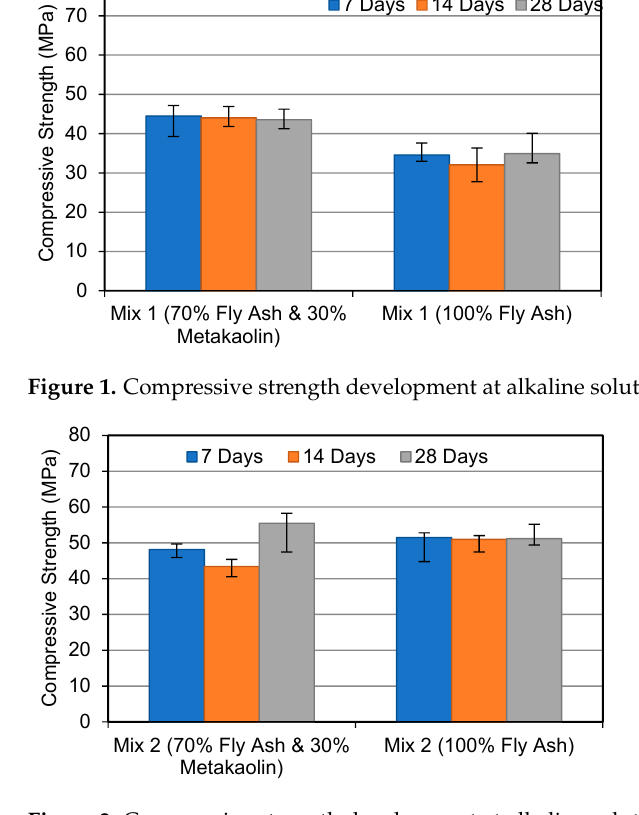
Figure 2. Compressive strength development at alkaline solution molar ratio 1.5.